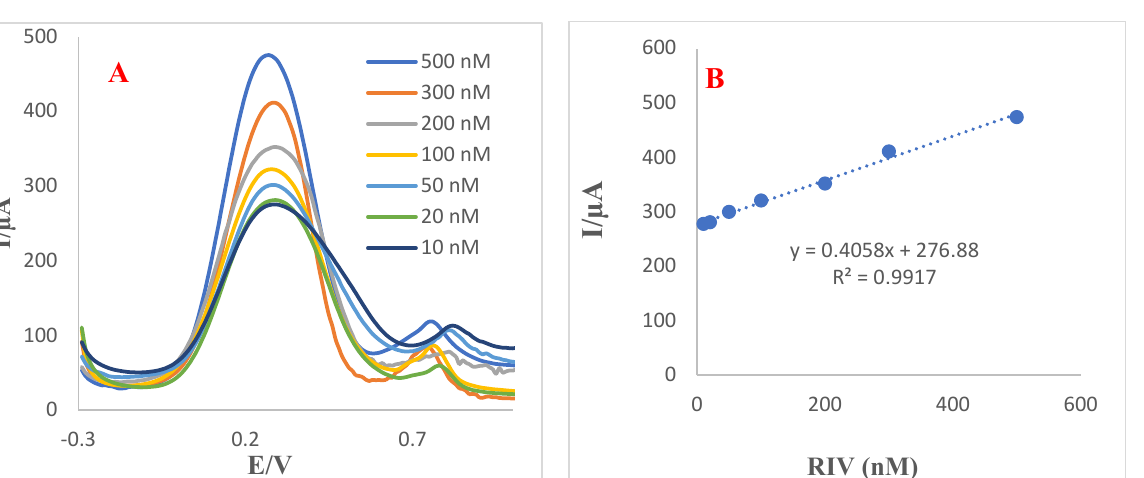
Table 1. Analytical figures of merit of previously developed methods toward determination of RIV in biological samples. Method